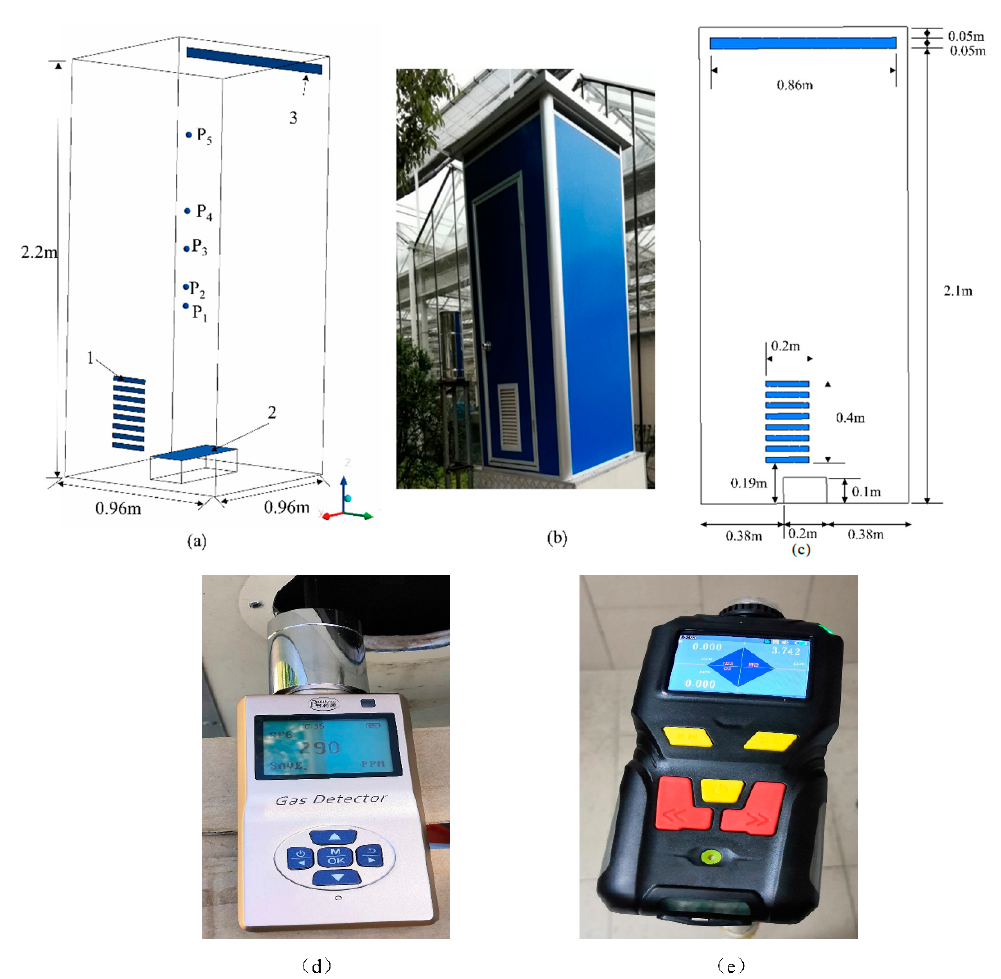
Figure 1. Research model geometry, gas detector, and monitoring points: P 1 (0.48, 0.48, 0.9), P 2 (0.48, 0.48, 1), P 3 (0.48, 0.48, 1.2), P 4 (0.48, 0.48, 1.4), P 5 (0.48, 0.48, 1.9); unit: m. 1—Grid, 2—Pollution source, 3—Window ( a ) Model diagram; ( b ) Test bench; ( c ) Front view; ( d ) XLA-BX-SF 6 gas detector; ( e ) PNT400-H2S/O3/NH3-G gas